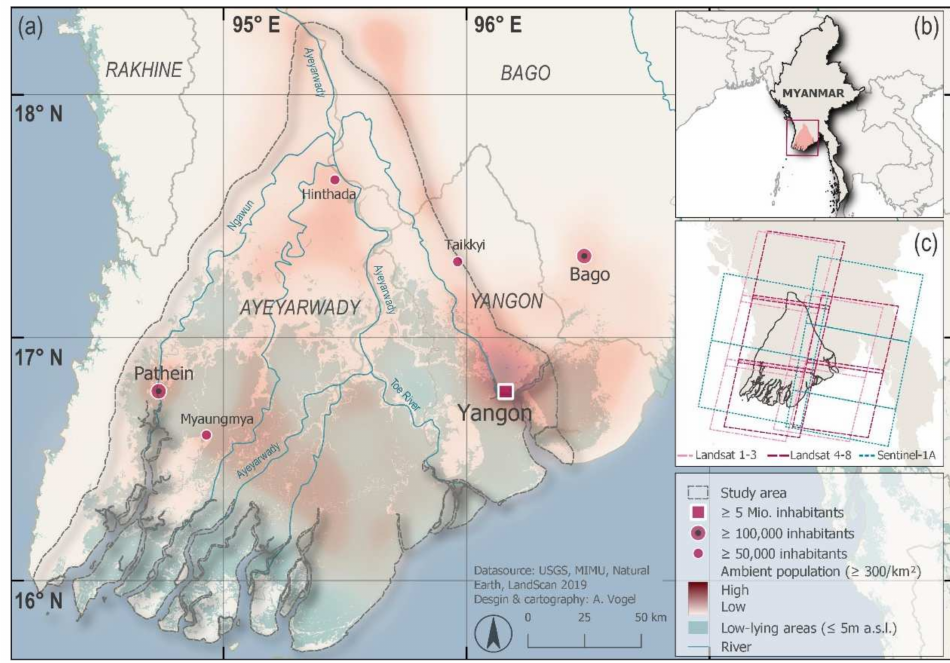
Figure 1. Location of the study area ( a , b ) and extents of utilized Landsat and Sentinel scenes ( c